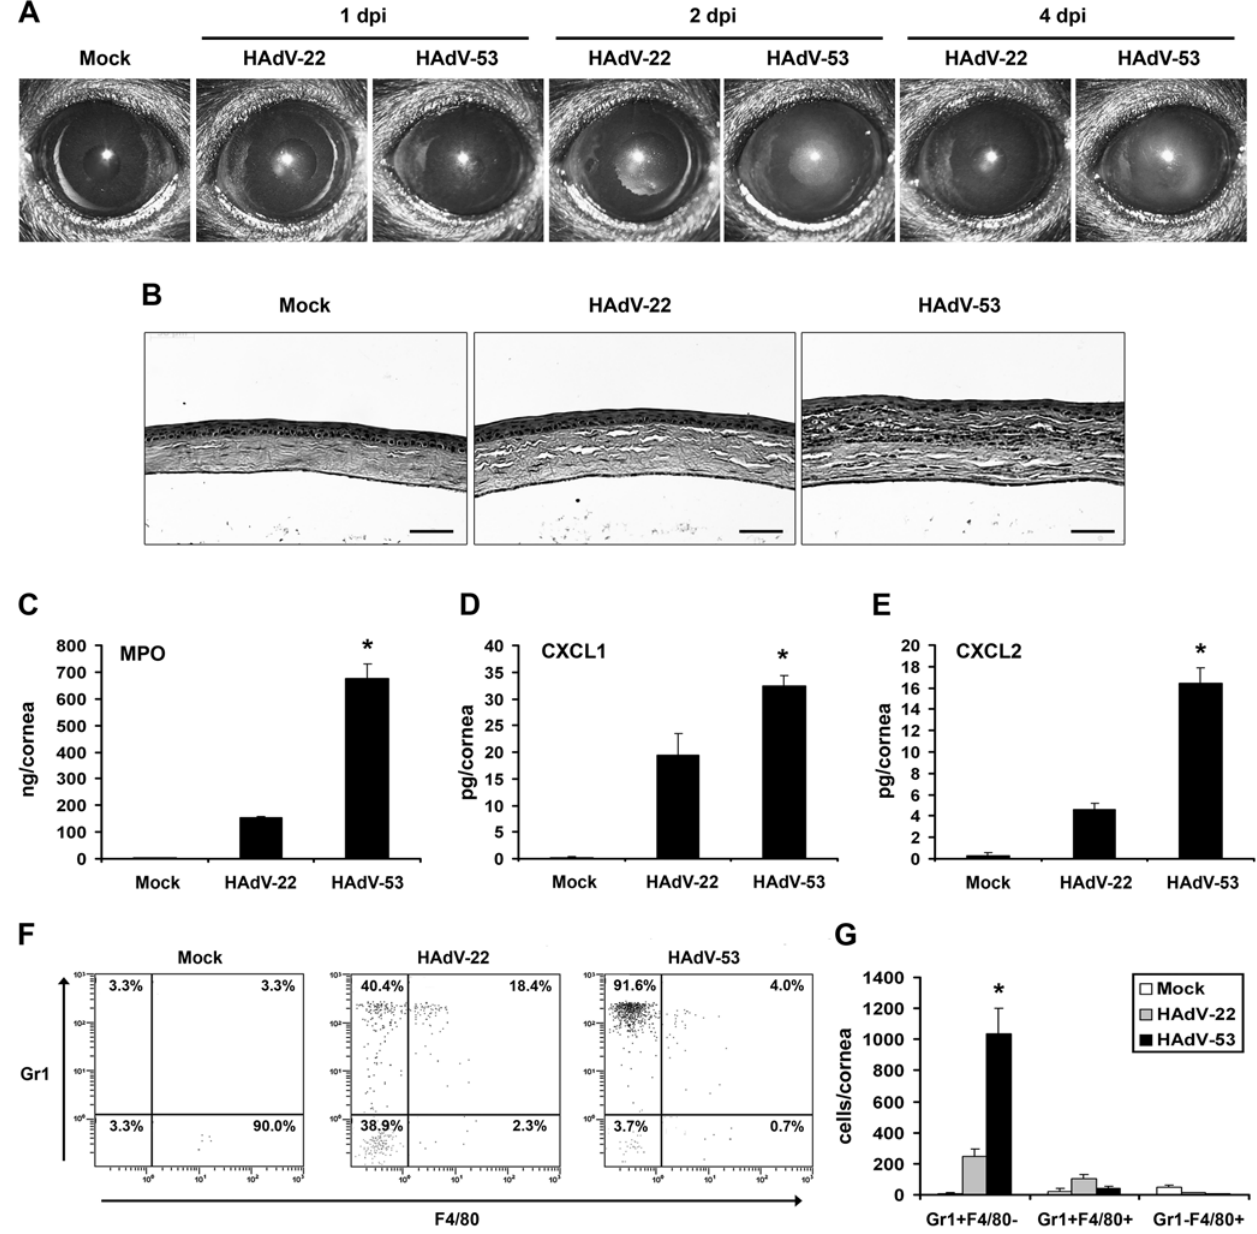
Figure 4. HAdV-D53 induces keratitis. (A) Clinical appearance of HAdV-D53 keratitis. Virus-free buffer (mock), 10 4 TCID of HAdV-D22, or HAdV- D53 was injected in the corneal stroma of C57BL/6 mice (n=8 corneas/group). Corneas were examined under a surgical microscope up to 4 days post-infection. One representative picture from each group is shown at the indicated time points. (B) Histopathology of HAdV-D53 keratitis. Representative histopathological sections at 4 days post-infection of mouse corneas injected with buffer, HAdV-D22, or HAdV-D53 are shown (hematoxylin and eosin stain; scale bar=50 m ). (C) Myeloperoxidase (MPO) expression in HAdV-D53 keratitis. Mock, HAdV-D22, and HAdV-D53 infected corneas were analyzed by ELISA at 24 hours post-infection for the expression of myeloperoxidase enzyme. (D, E) Chemokine expression in HAdV-D53 keratitis. Expression of CXCL1 (D) and CXCL2 (E) in mock, HAdV-D22, and HAdV-D53 infected corneas were analyzed by ELISA at 16 hpi. Data is mean 6 SEM from three individual experiments (n=9 corneas/group). (F, G) Phenotypic analysis of inflammatory cells in HAdV-D53 keratitis. Mock, HAdV-D22, and HAdV-D53 infected corneas at 24 hours post-infection were homogenized and single cell preparations were stained with anti- CD45, anti-Gr1, and anti-F4/80 antibodies. Cells were gated on CD45-positive staining. (F) Representative dot plots or (G) quantification of three separate experiments is shown for each group (mean cells/cornea 6 SEM, n=9 corneas/group). In all experiments statistical significance is denoted by *, P , .05 as determined by ANOVA with Scheffe’s multiple comparison